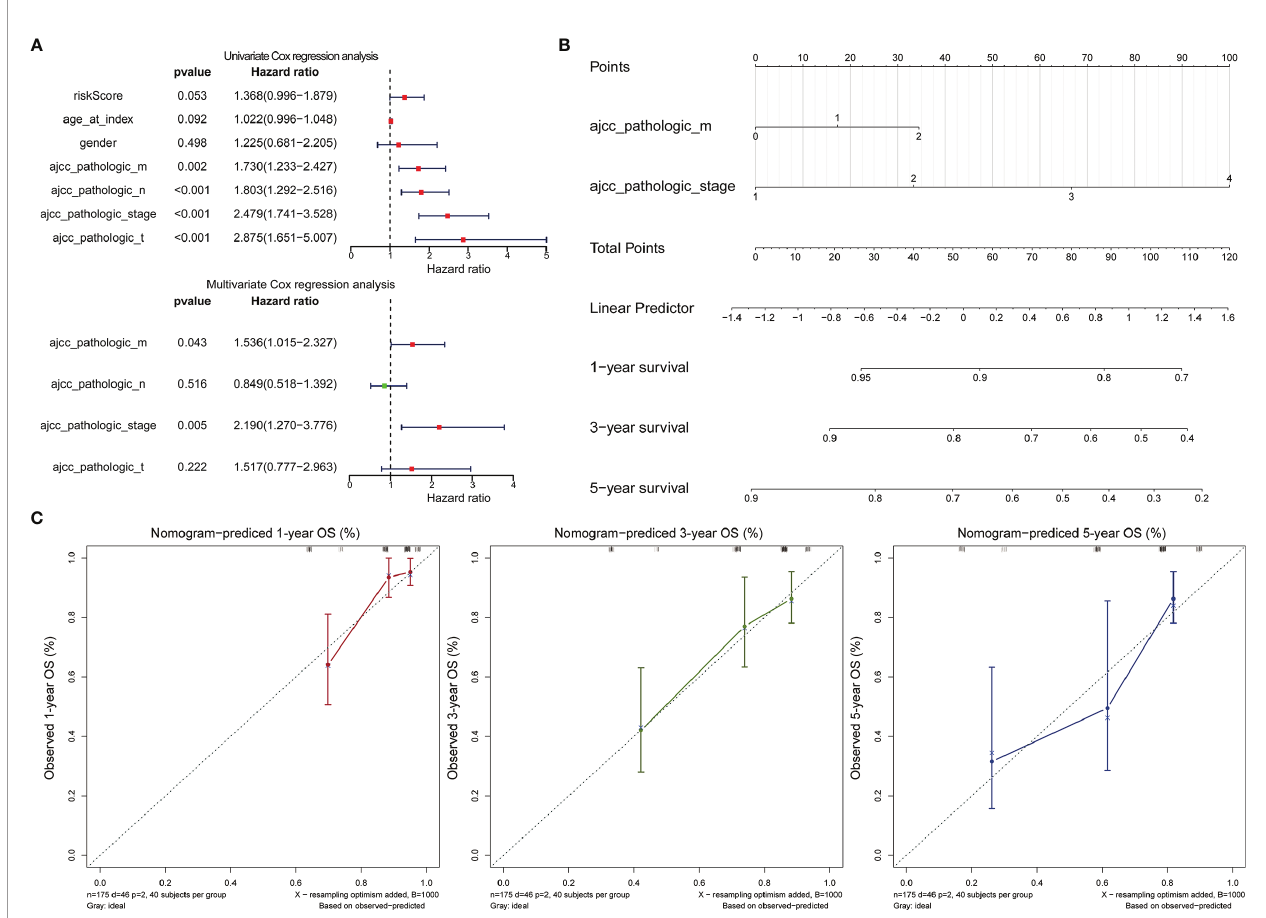
FIGURE 7 | Assessment of the prognostic risk model of the 2 DE-FRGs in RCRC. (A) The univariate (top) and multivariate (bottom) Cox regression analysis of risk score and clinical features regarding prognostic value. Clinical features: age, gender, ajcc pathologic t (tumor size), ajcc pathologic n (lymph node metastasis), ajcc pathologic m (distant metastasis), and ajcc pathologic stage. (B) Nomogram predicting OS for RCRC patients. For each patient, two lines are drawn upward to determine the points received from the predictor in the nomogram. The sum of these points is located on the ‘ Total Points ’ axis. Then a line is drawn downward to determine the possibility of 1-, 3-, and 5-year OS of RCRC. (C) The calibration plot for internal validation of the Nomogram. The Y-axis represents actual survival, and the X-axis represents nomogram-predicted